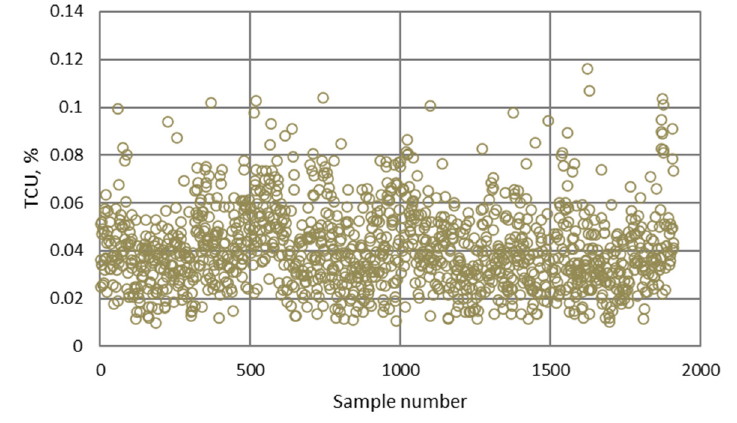
Figure A38. NN3 model—training dataset.